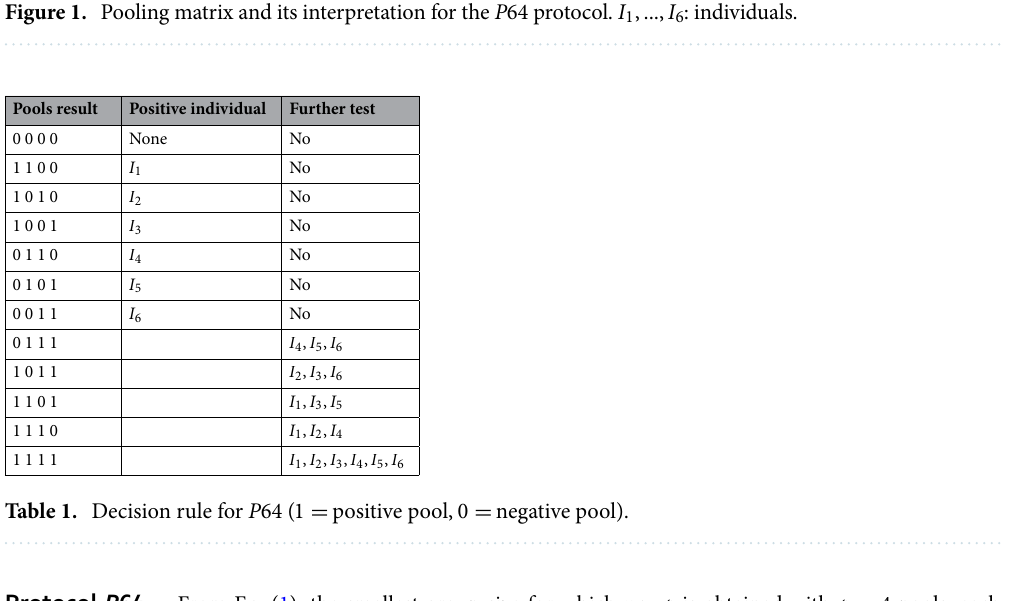
Figure 1. Pooling matrix and its interpretation for the P 64 protocol. I 1 , ..., I 6 : individuals.